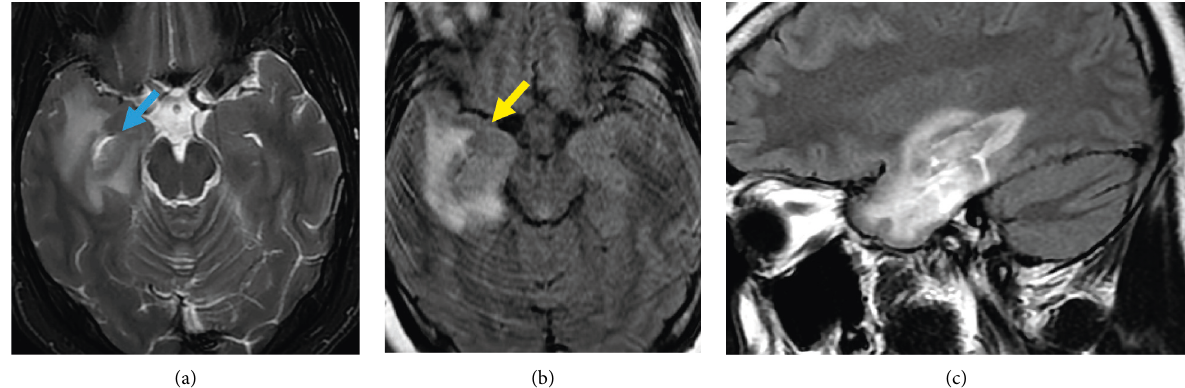
Figure 1: Axial T2-weighted (a), axial FLAIR (b), and sagittal FLAIR (c) views of MRI brain showing CNS relapse. Images show T2 isointense-hypointense signal in right inferior temporal lobe with peripheral edema causing expansion of the uncus (yellow arrow) without mass effect on temporal horn of right lateral ventricle (blue arrow).